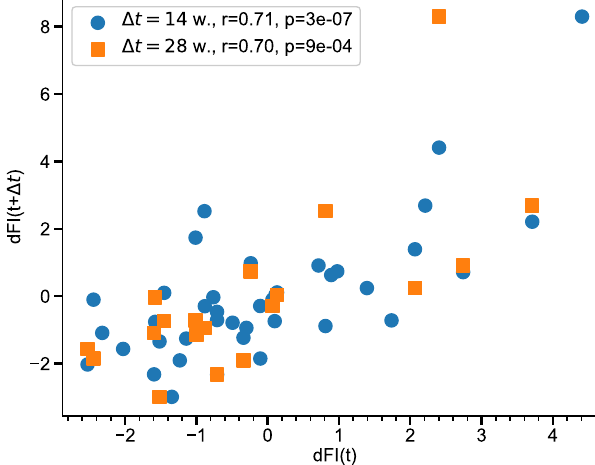
Fig. 2 | Auto-correlation property of the dynamic frailty indicator (dFI). Cor- relation between age-adjusted dFI values across sampling intervals Δ t of 14 (blue circles, animals n =40) and 28 (orange squares, animals n =19) weeks in the vali- dation MA0072 dataset. Two-sided p values were calculated for the Pearson cor- relation coef fi cient.